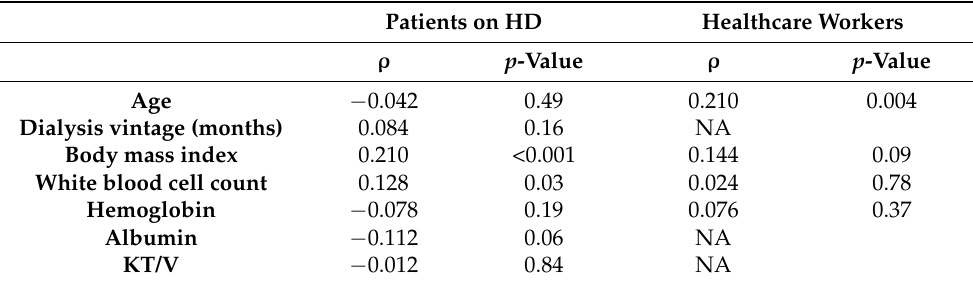
Table 5. Correlation between continuous parameters and rate of increase in anti-spike immunoglobu- lin G antibody levels from October 2021 3 weeks after the third dose of BNT162b2. Patients on HD